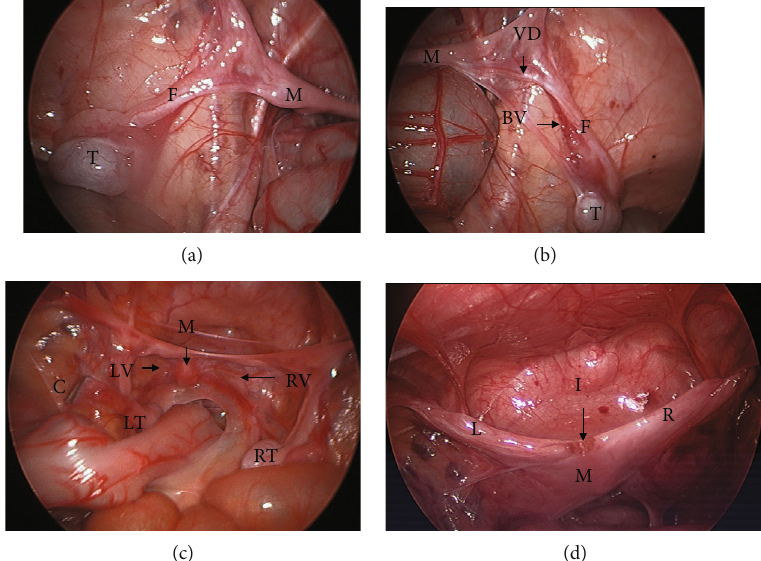
Figure 1: (a) Diagnostic laparoscopy showing the left testicle and fallopian tube-like structure. Key: M: persistent Müllerian duct structure; F: fallopian tube-like structure; T: left testicle. (b) The right testicle and fallopian tube-like structure. Key: M: persistent Müllerian duct structure; F: fallopian tube-like structure; T: right testicle; VD: right vas deferens closely associated with fallopian tube-like structure; BV: blood vessels along vas and fallopian tube-like structure. (c) Laparoscopic view showing completed fi rst-stage FSO bilaterally. Key: M: persistent Müllerian duct structure; RV: right vas deferens; RT: right testis; LV: left vas deferens; LT: left testis; C: clips on the distal end of left gonadal vessels. (d) Laparoscopic view illustrating completed second-stage bilateral FSO. Small midline incision at the dome of persistent Müllerian duct structure was made to allow tension-free orchidopexy. Key: M: persistent Müllerian duct structure; I: midline incision in the Müllerian duct structure; R: right fallopian tube-like structure with associated vas and blood vessels exiting the abdominal wall; L: left fallopian tube-like structure with associated vas and blood vessels exiting the abdominal